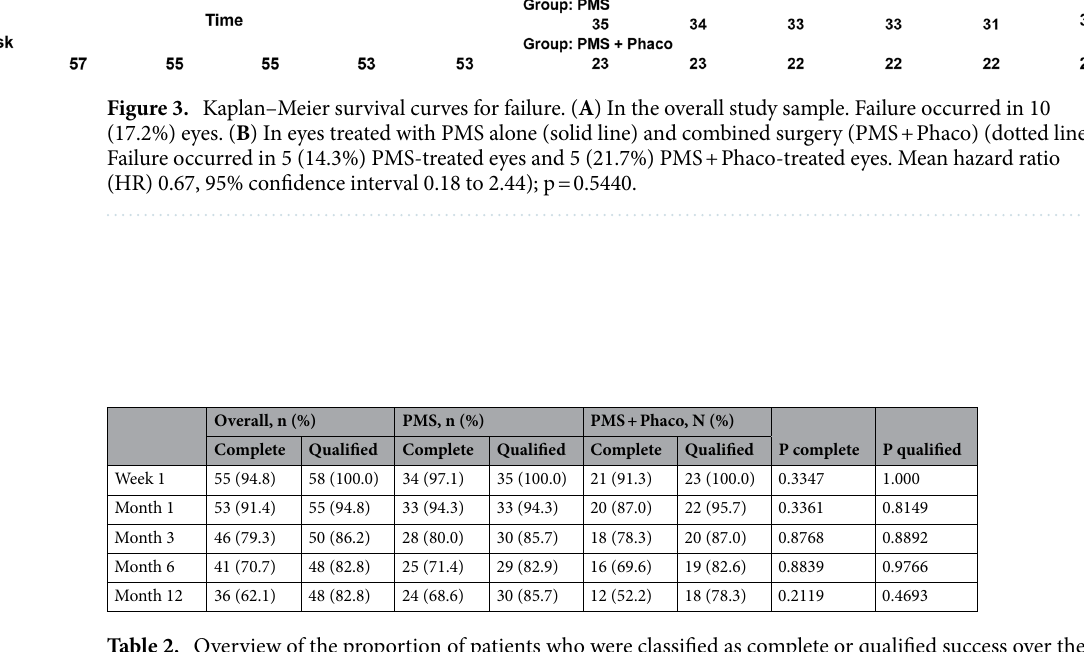
Table 2. Overview of the proportion of patients who were classified as complete or qualified success over the course of the study follow-up. PMS Preserflo Microshunt.